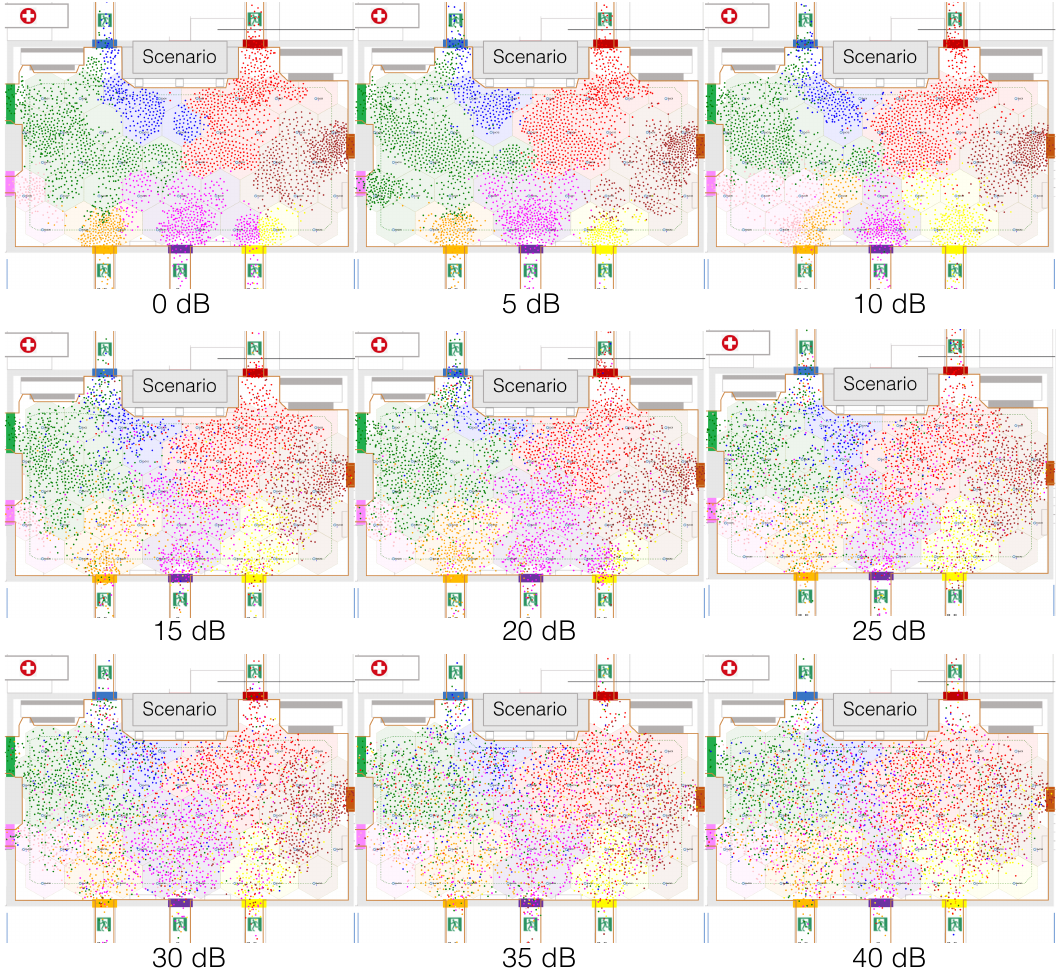
Figure 6. Still images 25 s after the start of the evacuation from single run simulation experiments for different standard deviation values σ g . The cells are shaded with the exit-gate color allocated by the controller node. Colored dots represent pedestrians with the colors shown by their LED